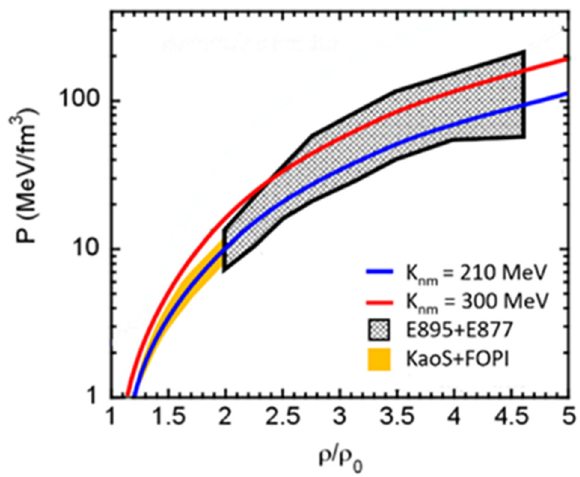
Figure 16. EOS of symmetric nuclear matter expressed as pressure versus baryon density. Grey hatched area: constraint from proton flow data taken at AGS [11,12]. Yellow area: Constraint from fragment flow and kaon data taken at GSI [54,55,59]. Red line: Hard EOS. Blue line: Soft EOS [12].